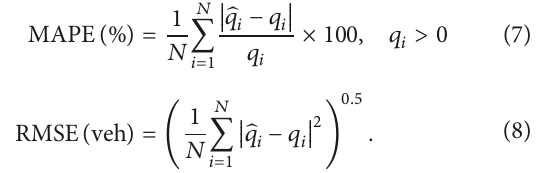
Algorithm 1. The KNN-S2S algorithm is designed for